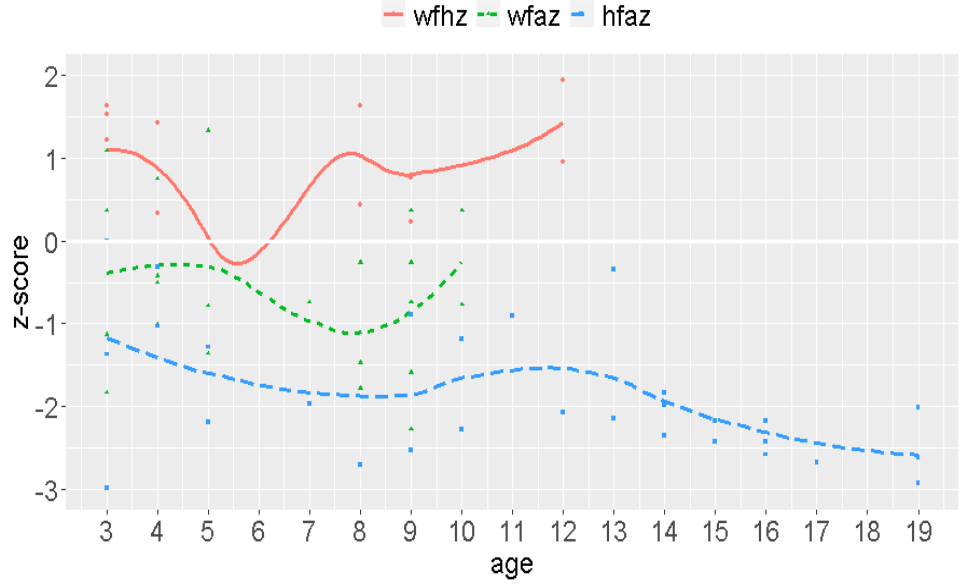
Figure 5. Weight-for-height (wfhz), weight-for-age (wfaz), height for age (hfaz) z-scores.